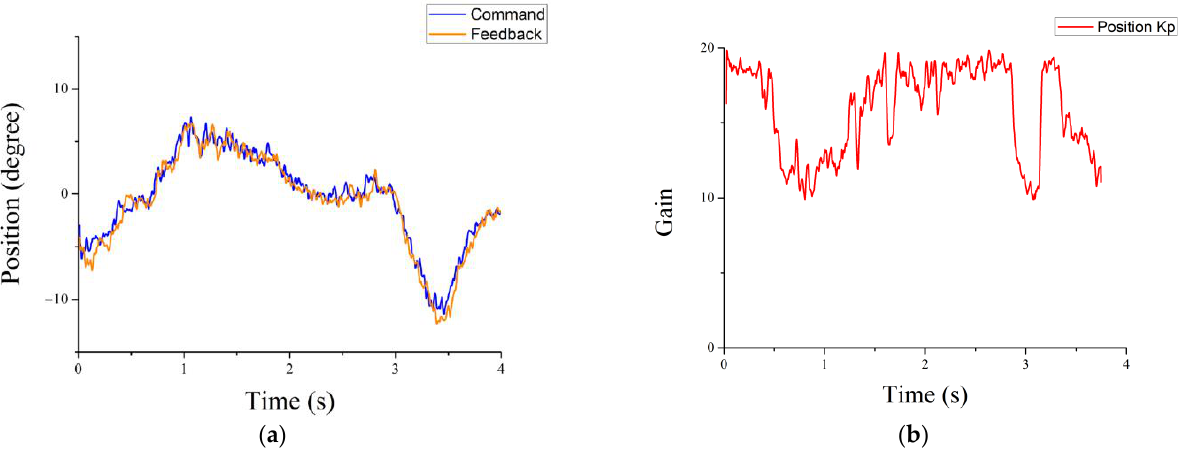
Figure 21. ( a ) Tracking performance of the hip by the self-tuning controller; ( b ) controller gains of the hip by the self-tuning controller.